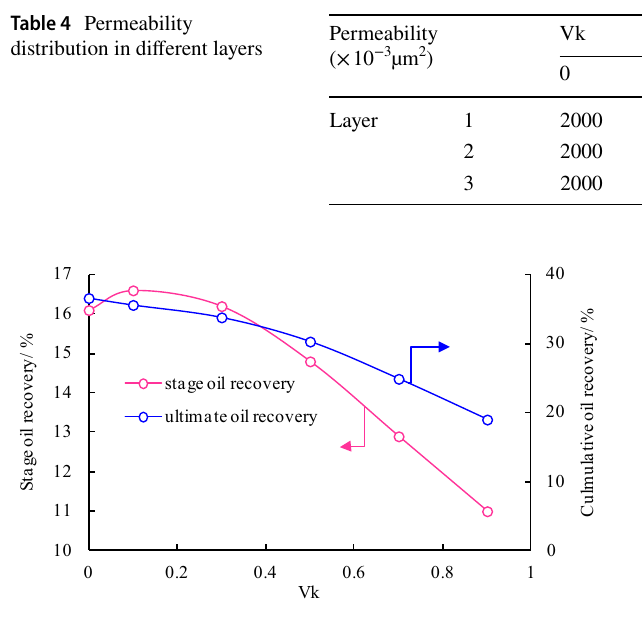
Fig. 10 Oil recovery variation with